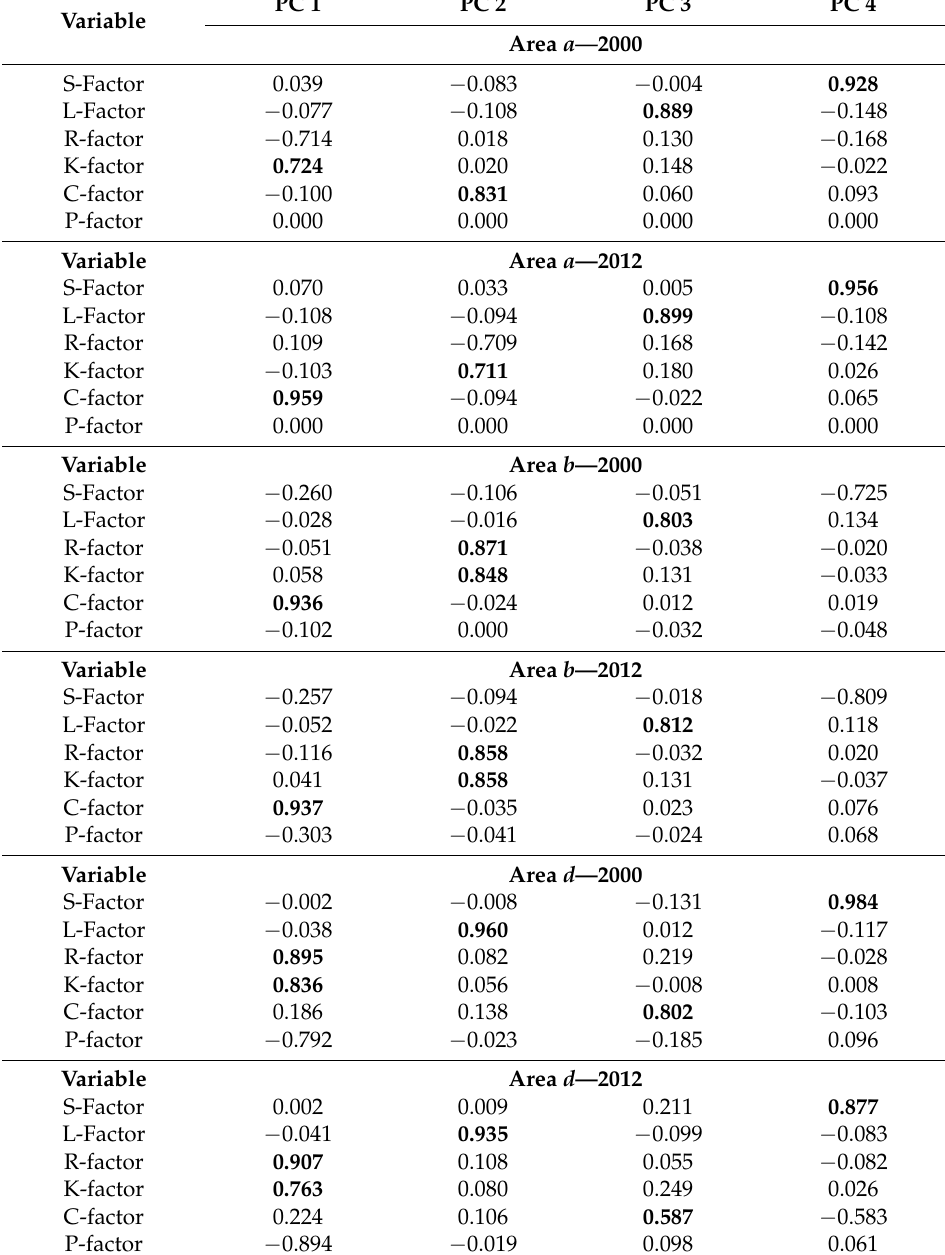
Table 8. Results of principal component analysis (PCA) (Varimax rotated component matrix) for the areas a , b and d , of the Brazilian Cerrado. Bolding numbers indicate the most significant variables for each principal component